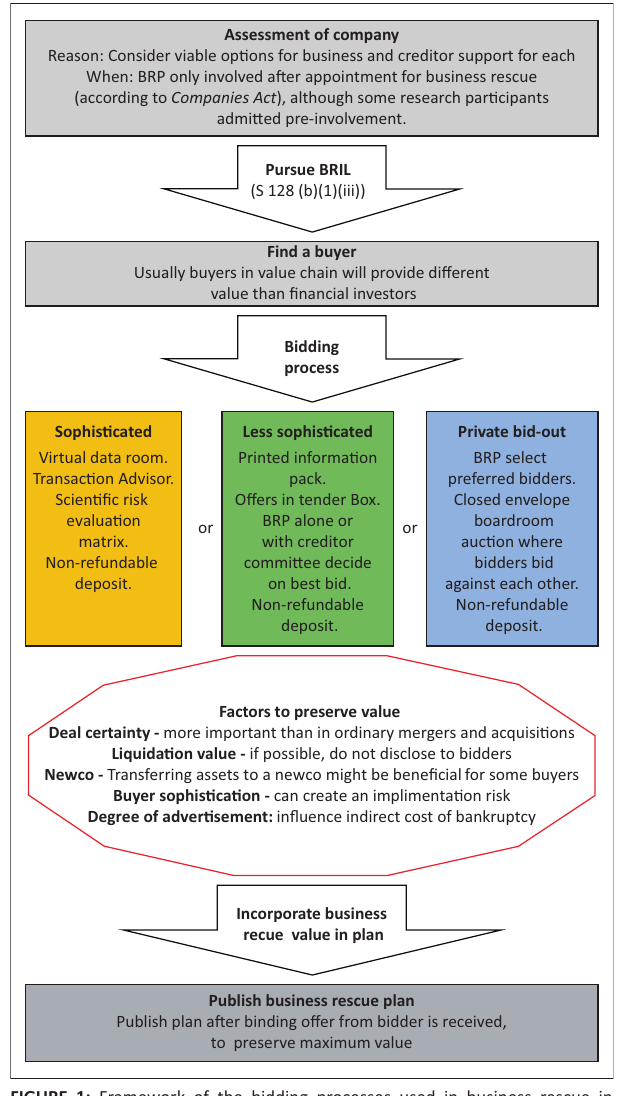
FIGURE 1: Framework of the bidding processes used in business rescue in South